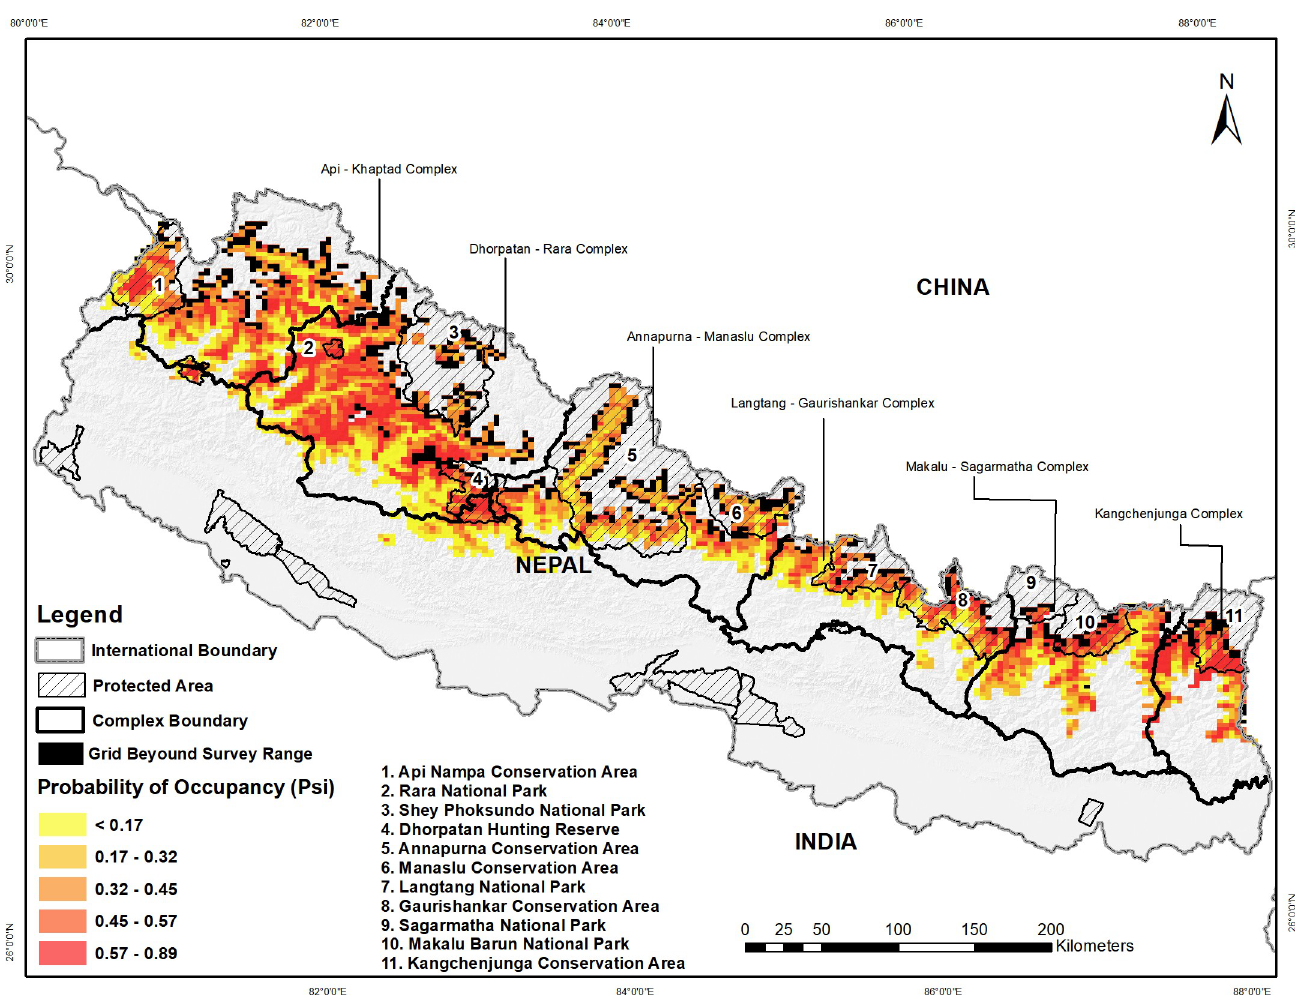
Fig 3. Site specific variation in red panda occupancy based on top model along the mid-hills and high mountains of Nepal. Grid shading (with darker red color indicating higher probability of occupancy) shows site specific occupancy probabilities in the wet season of 2016 using single-species, single-season occupancy model. Grid with dark color shows area beyond the survey